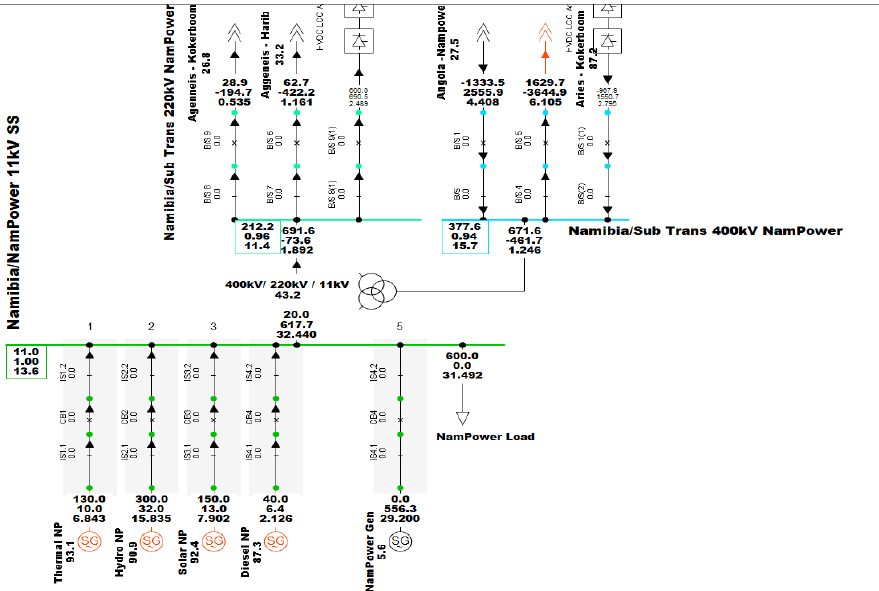
Figure 10. Voltage instability in the Namibia electric network.